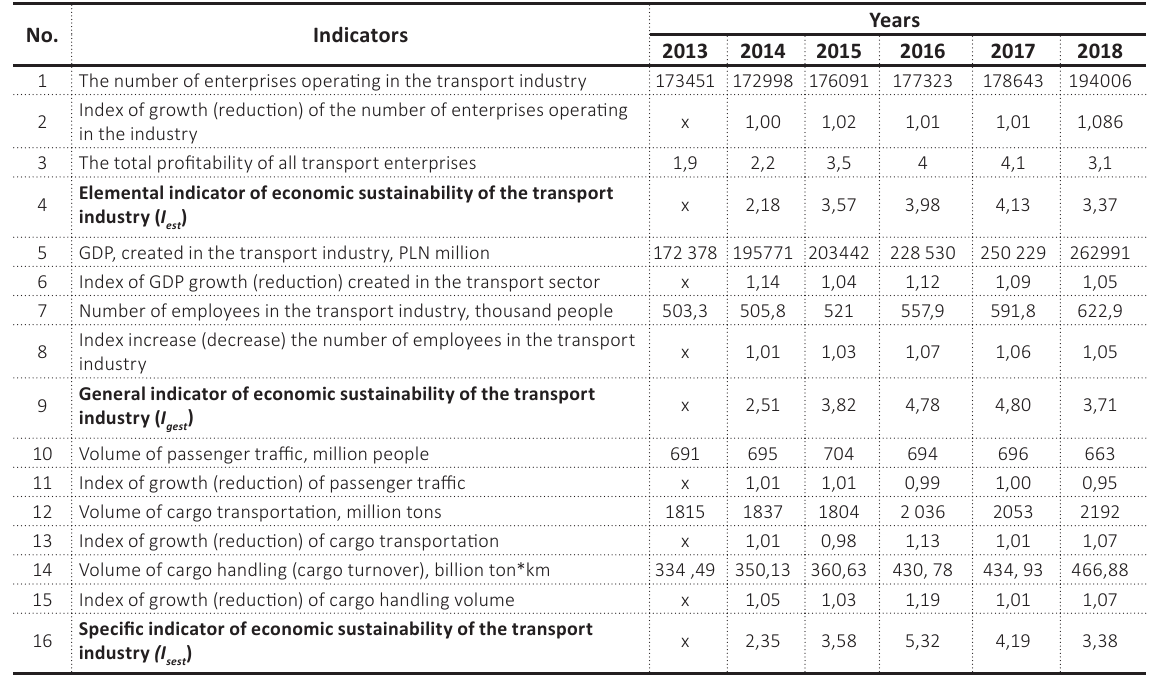
Table 3. Dynamics of indicators of economic sustainability of transport industry of Poland for